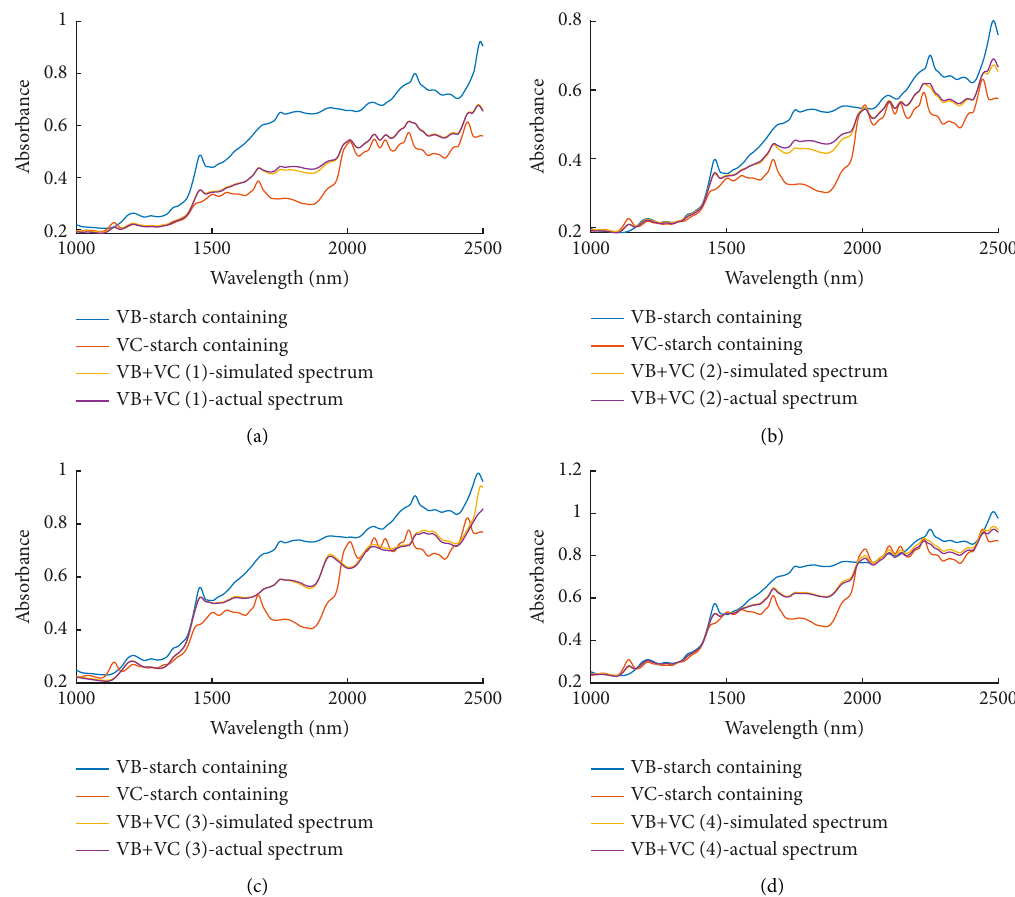
Figure 1: Single sample spectra, the actual mixed spectra, and the corresponding simulated mixed spectra of (a) samples VB +VC